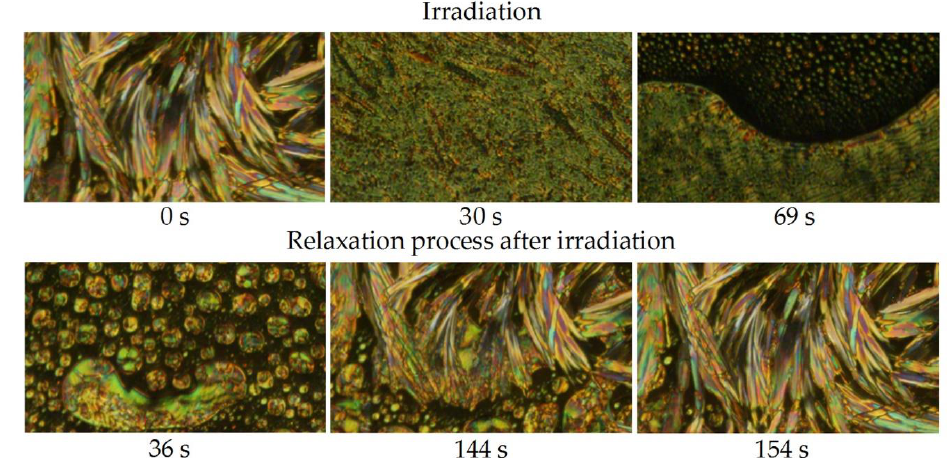
Figure 6. Photos of structural changes in Cr phase of the material IIa in a planar ITO-cell at 65 °C observed in POM: before irradiation (0 s); during UV-light (365 nm) irradiation in time (30 s, 69 s) and after irradiation (relaxation process) in time (36–154 s). The whole transition is documented in a supplementary video file Mov_Fig6.